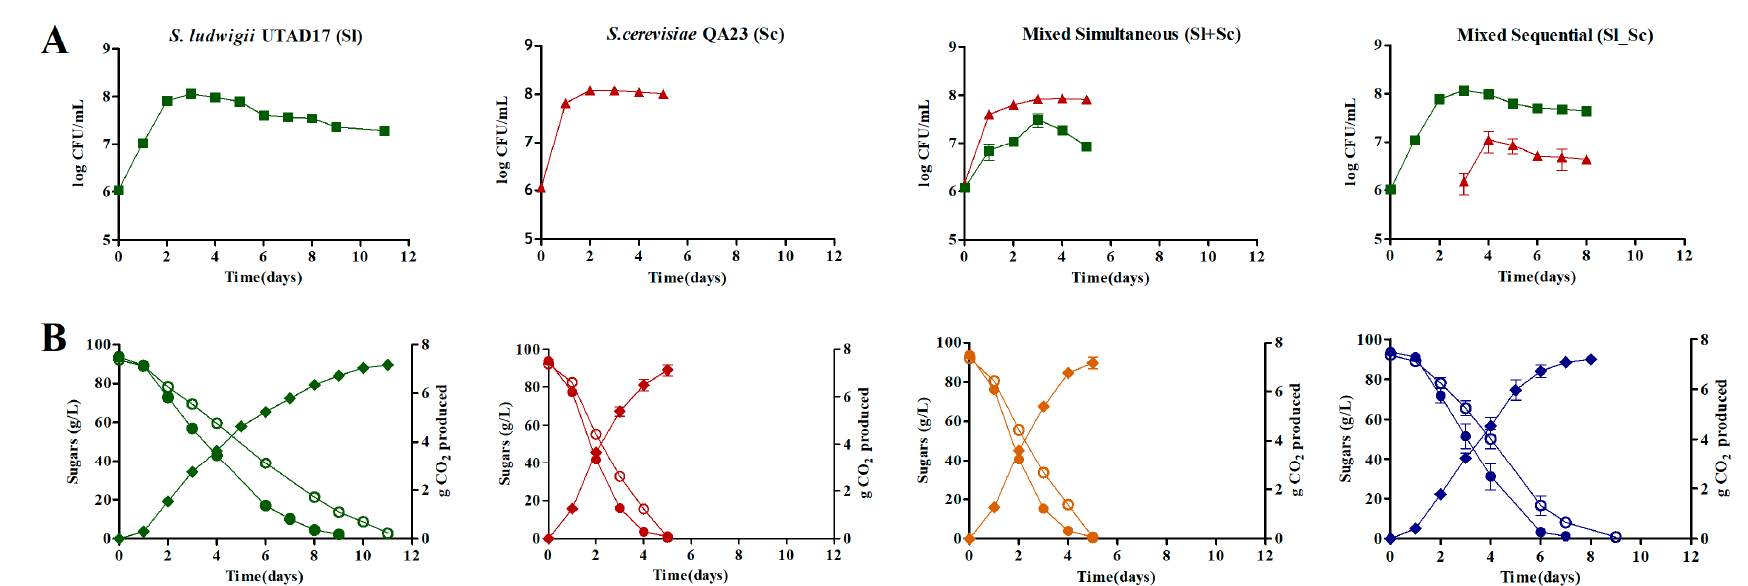
Figure 1. Means ± standard deviations of ( A ) yeast cell counts of S. ludwigii UTAD17 (green squares) and S. cerevisiae QA23 (red triangles) in single and mixed cultures; and ( B ) Fermentation profiles (diamonds), glucose (filled circles), and fructose (clear circles) concentrations during single and mixed culture trials.